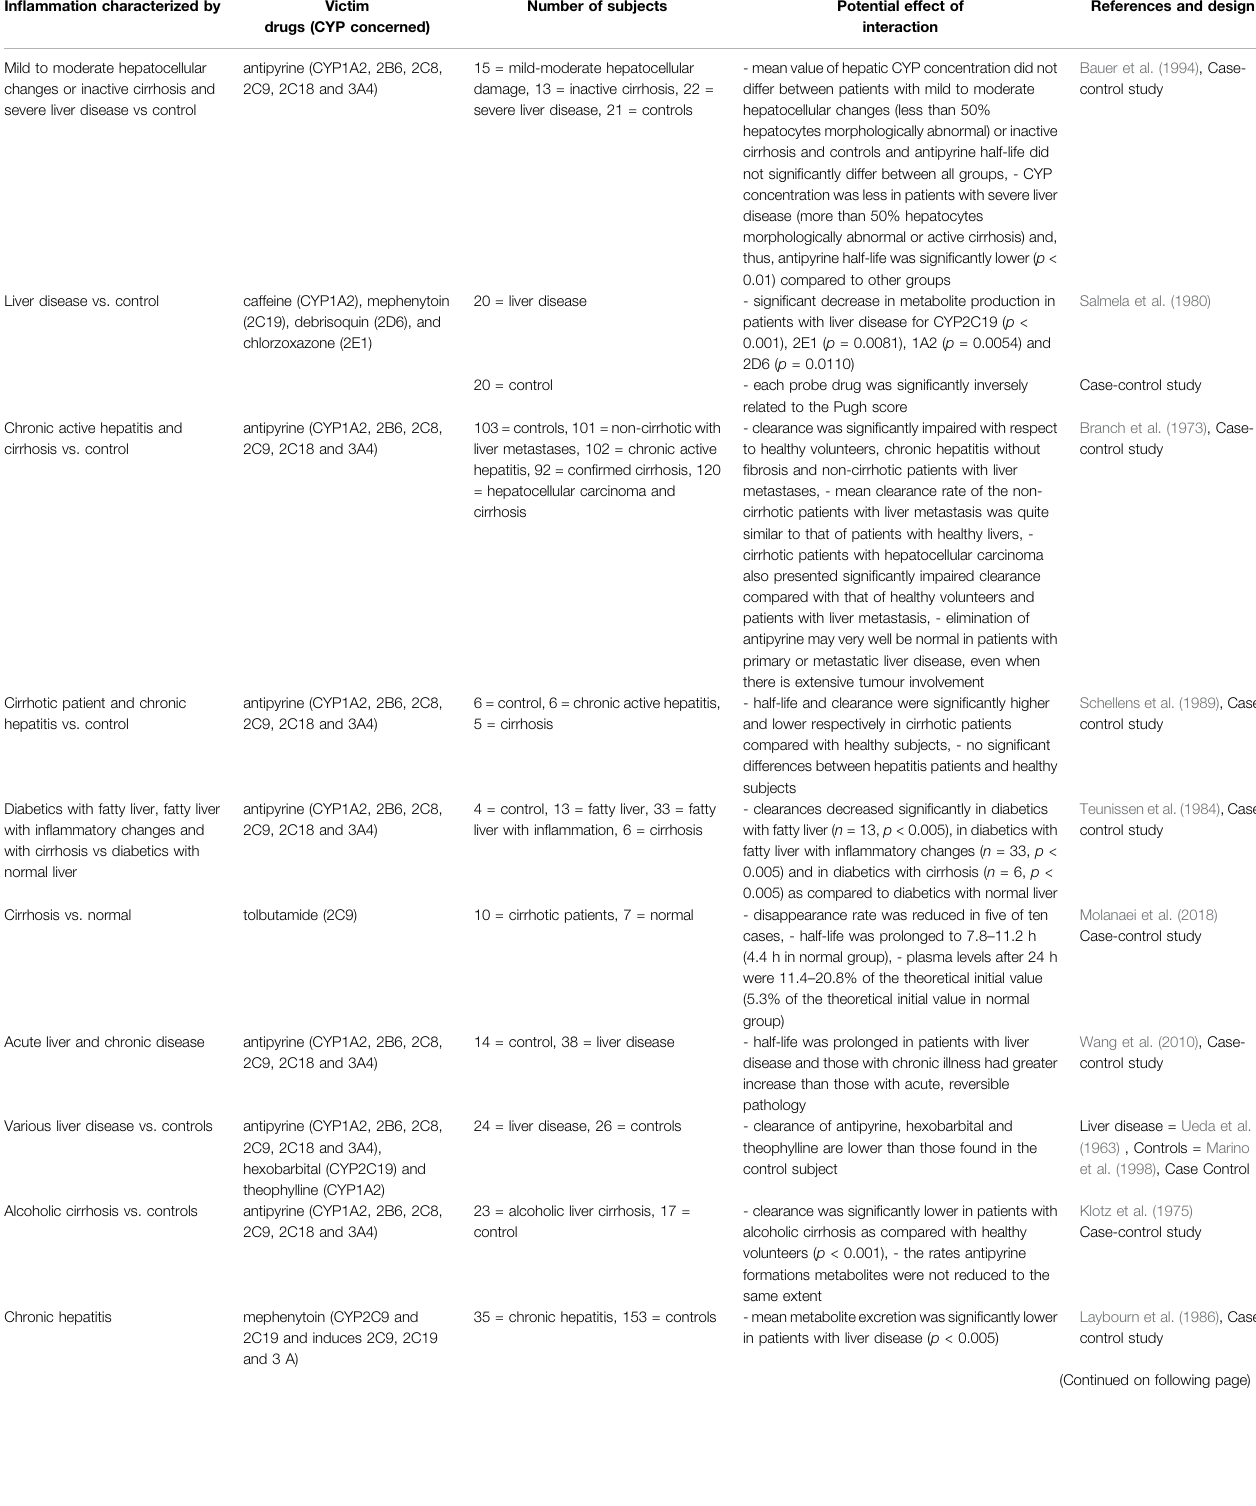
TABLE 5 | Impact of liver diseases on CYP substrates, explained totally or partially by modulation of CYP activity. In fl ammation characterized by